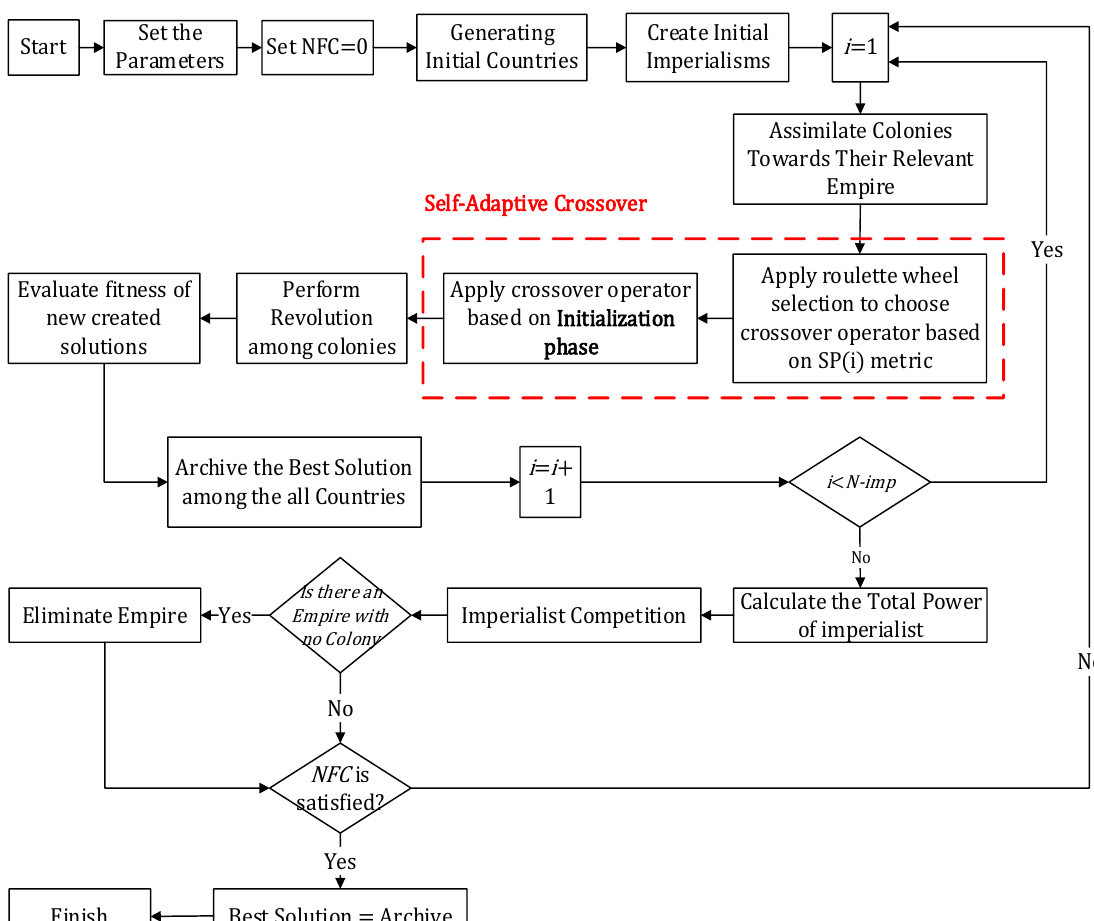
Figure 7. Flowchart of the main